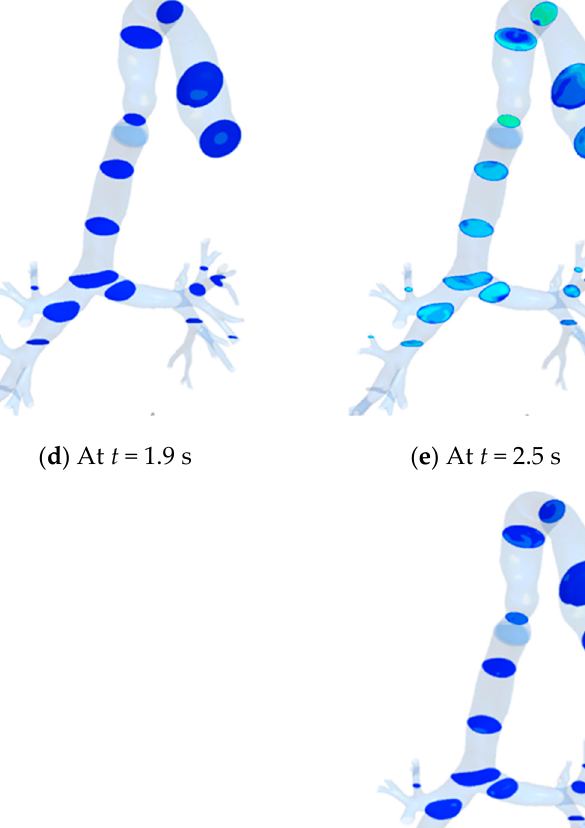
( d ) At t = 1.9 s ( e ) At t = 2.5 s ( f ) At t = 3 s